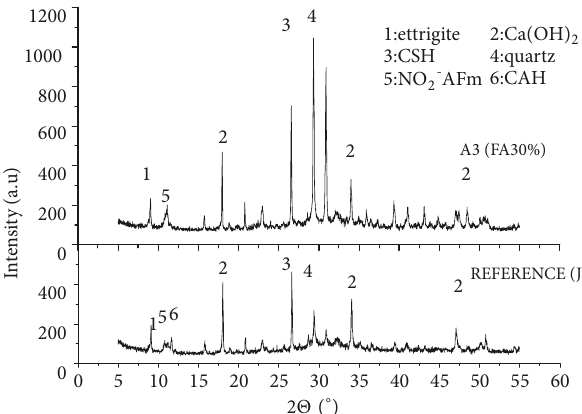
Figure 5: The X-ray diffraction pattern of the sample mixed with 30% slag and the reference